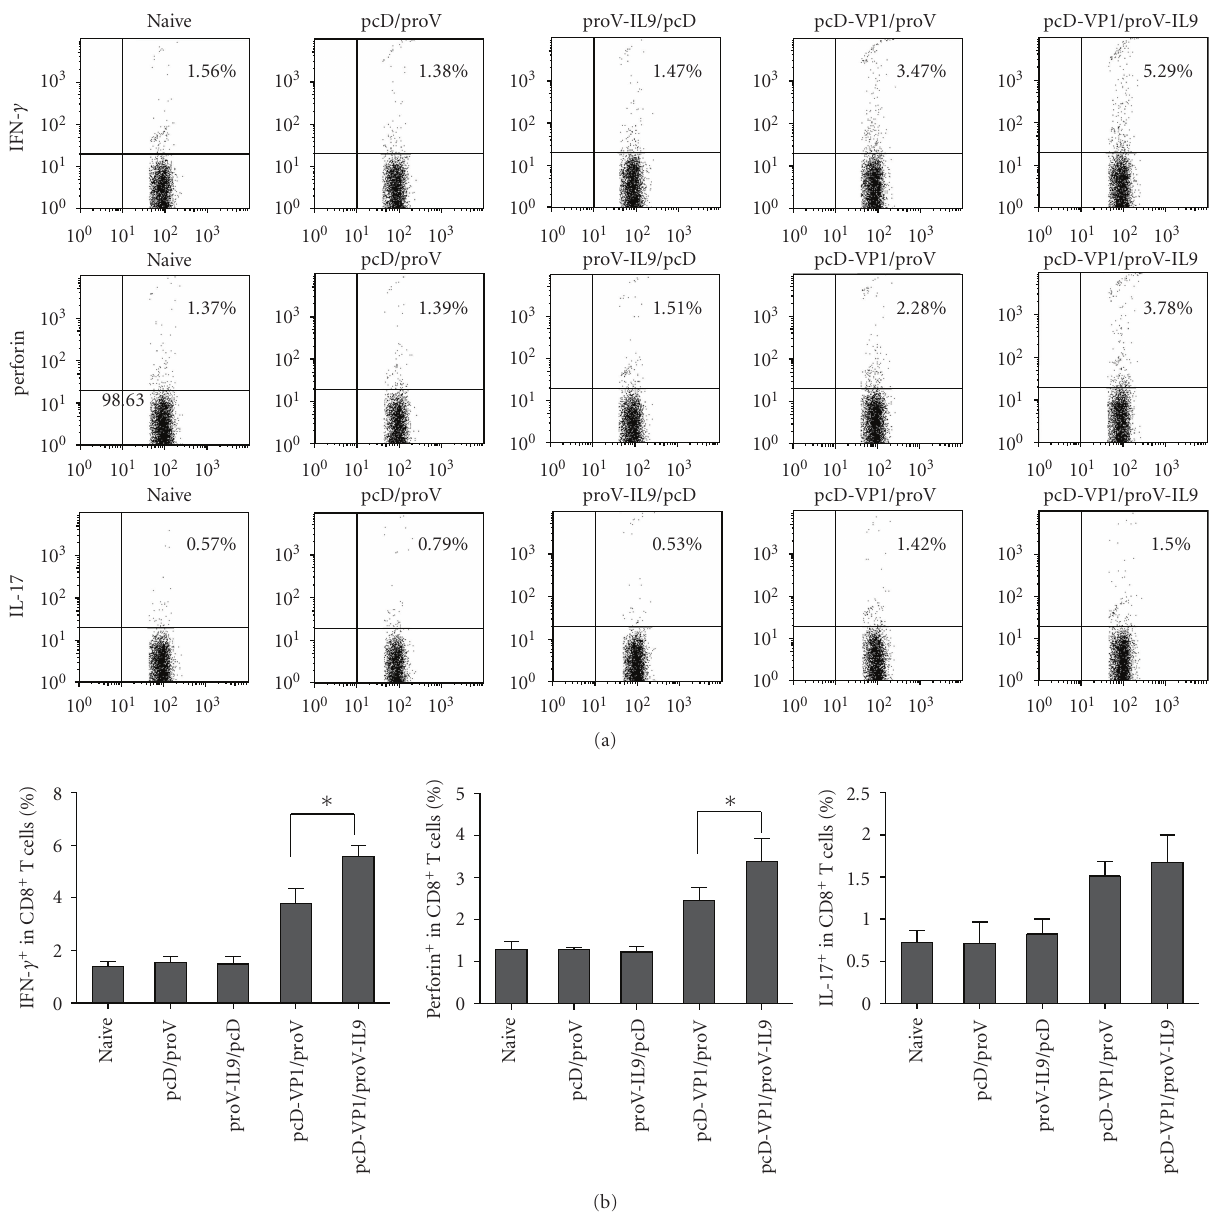
Figure 4: Analysis of antigen-specific cytokine productions in CD8 + T cells by FACS. (a) CD8 + T cells isolated from the spleen of C57BL/6 mice on day 7 after the final boost were stimulated with VP1 peptide for 4 h in culture. Intracellular staining for IFN- γ , perforin, and IL-17 in CD8 + T cells was performed. (b) The summaries of percentage were shown in the means of the three independent